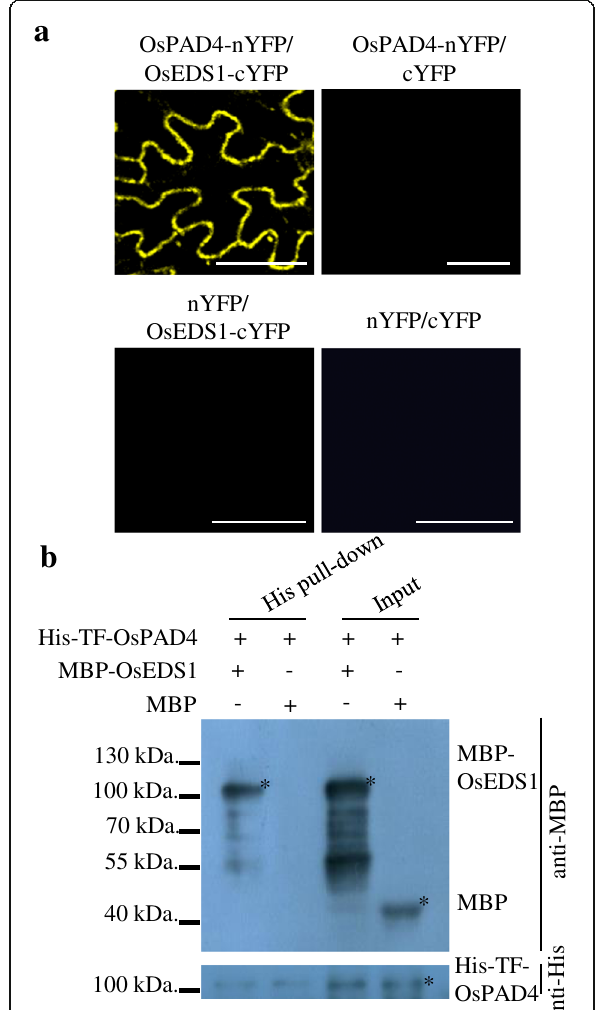
Fig. 1 OsPAD4 directly interacted with OsEDS1. a OsPAD4 interacts with OsEDS1. BiFC analysis of OsEDS1 and OsPAD4 interaction. Fluorescence can be observed only in tobacco ( Nicotiana benthamiana ) cells co-transfected with OsPAD4-nYFP and OsEDS1-cYFP plasmids. Bars indicate 50 μ m. b Protein pull-down assay for detection of His-TF-OsPAD4 and MBP-OsEDS1 interaction. Ten micrograms of His-TF-OsPAD4 coupled beads were used to pull down 5 μ g MBP or MBP-OsEDS1 protein. Anti- MBP antibody was used to detect output protein. Anti-His antibody was used to detect input